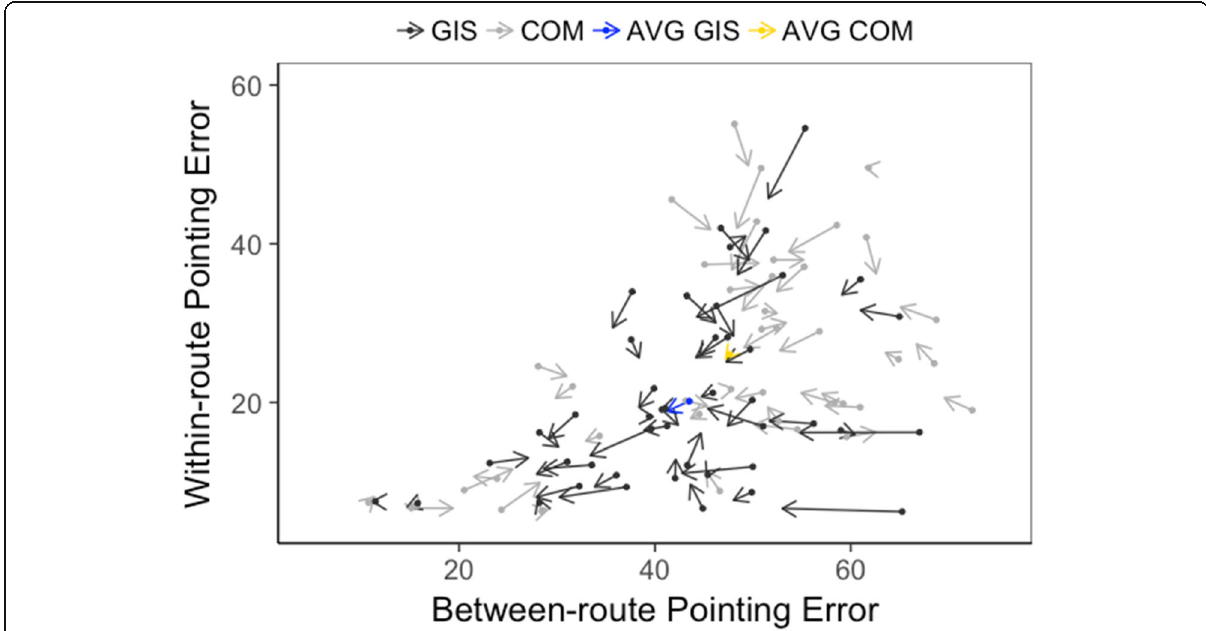
Fig. 6 Quiver plot of performance on between-route and within-route pointing trials at T1 and T2 grouped by participant course. Arrows depict the magnitude (scaled) and direction of change in performance from T1 to T2. AVG average, COM Communication, GIS Geographic Information Systems, T1 pre test (start of academic semester), T2 post test (end of academic